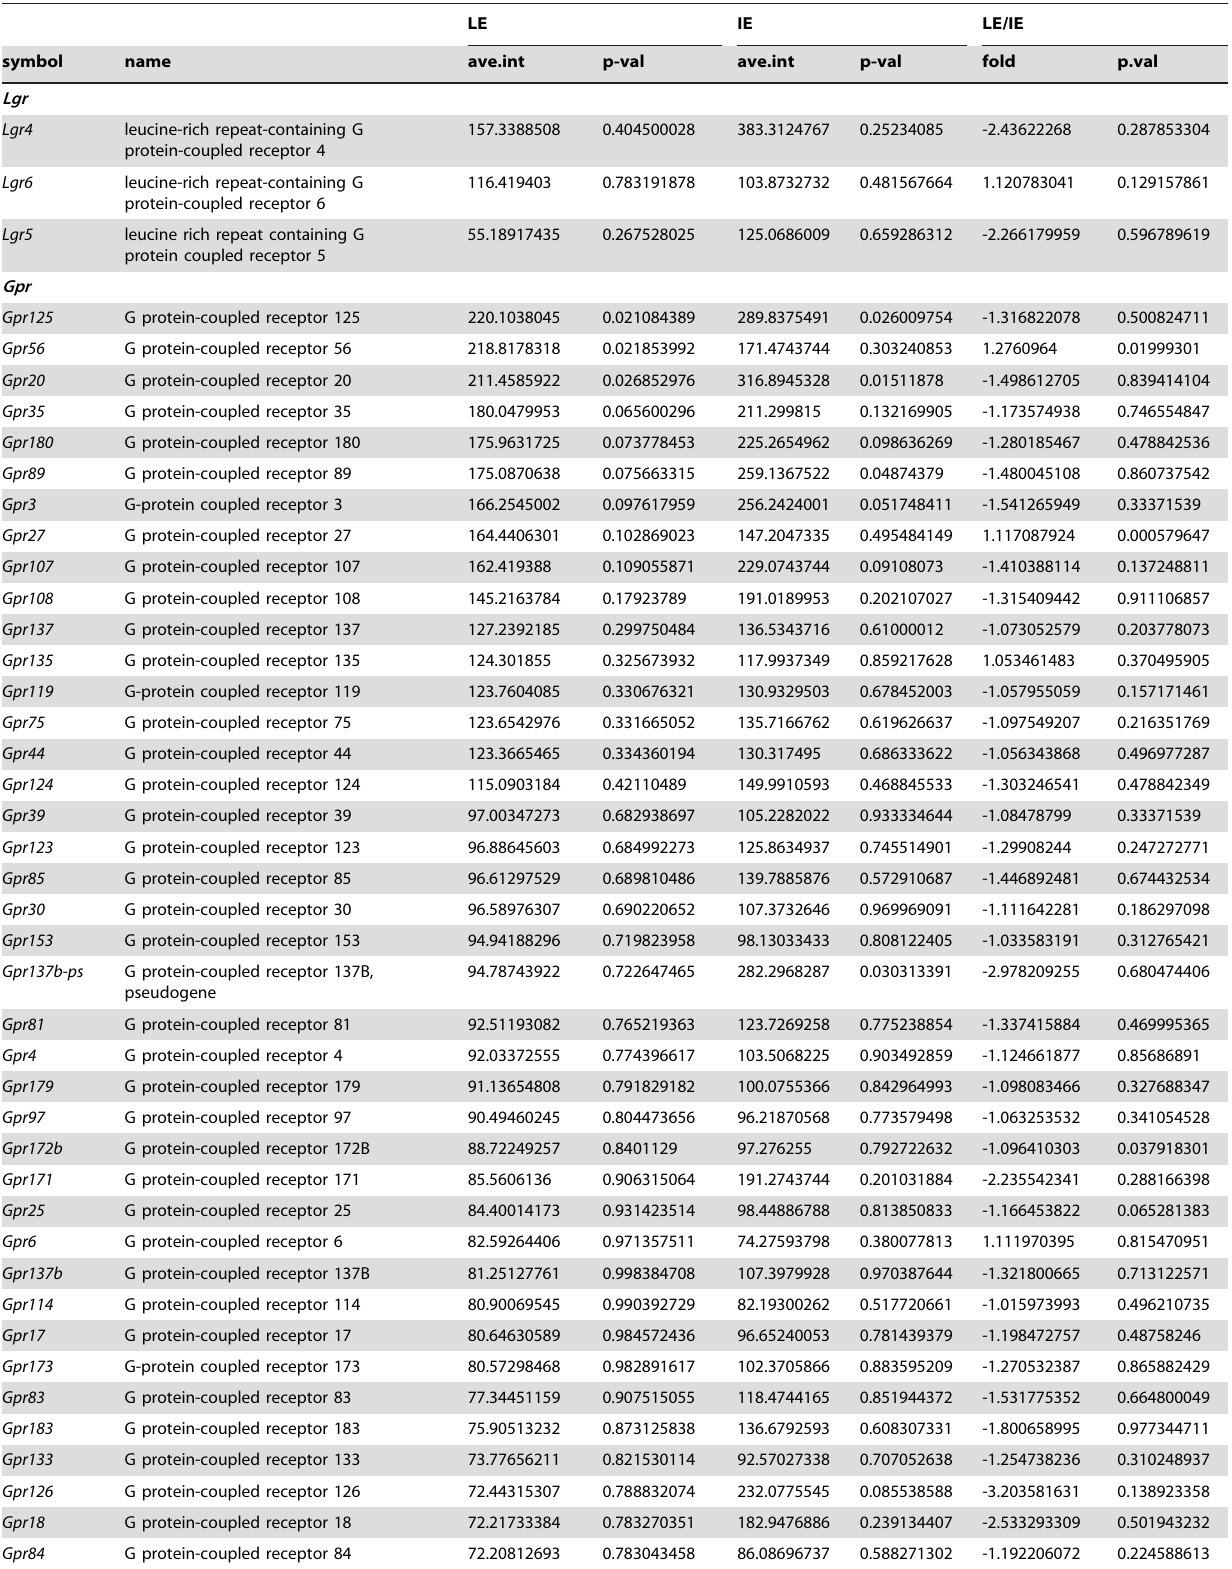
Table 4. Expression of genes in the Lgr and Gpr